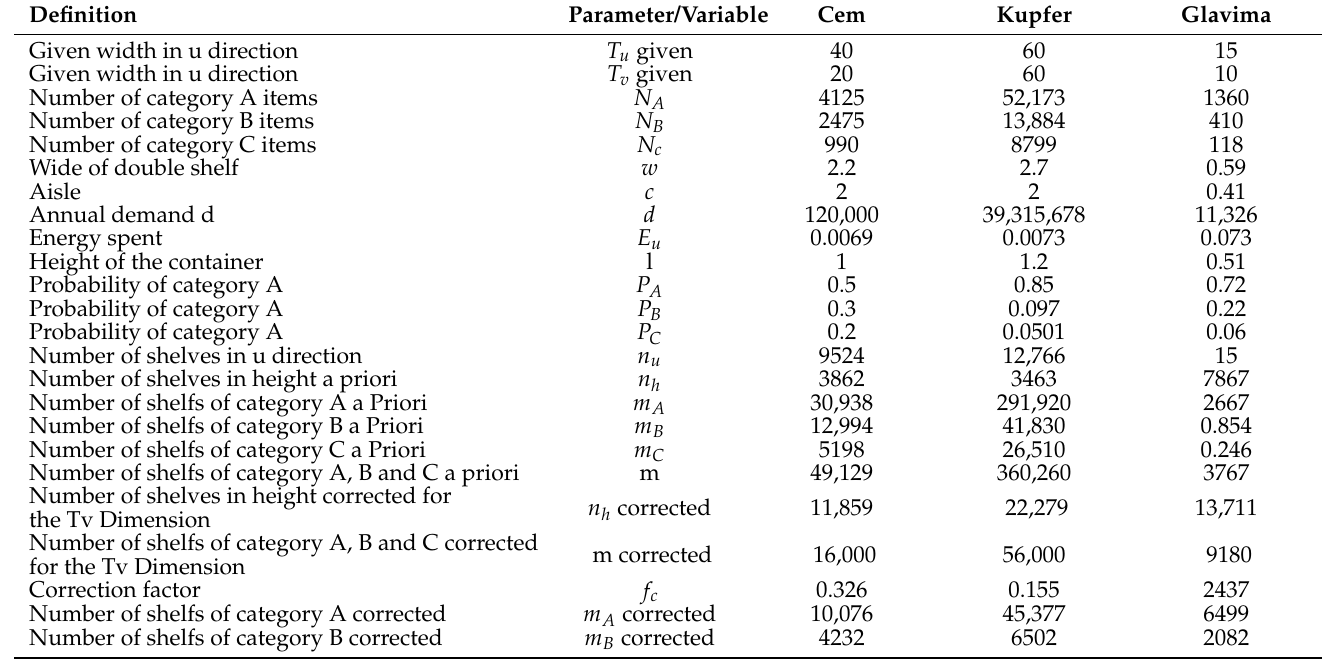
Table 9. Calculation with restricted